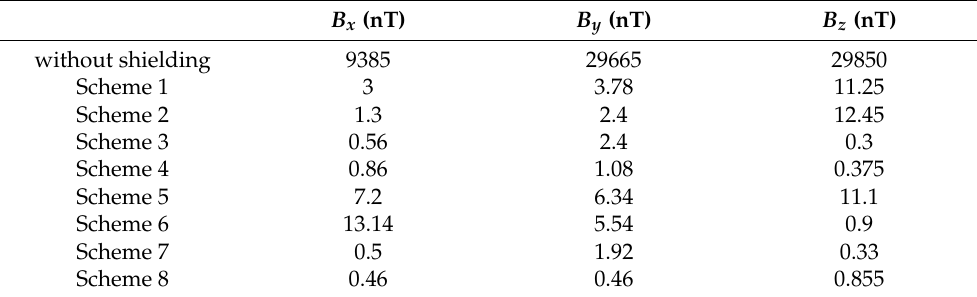
Table 1. Triaxial residual magnetic field after demagnetization of combined magnetic shielding system with different amorphous and nanocrystalline material as inner shield.